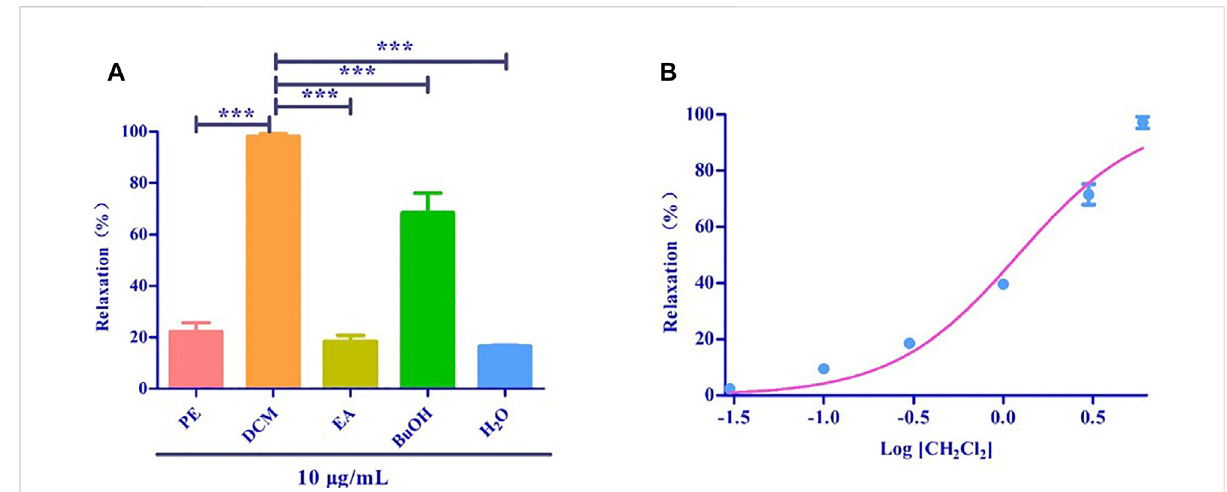
FIGURE 3 (A) Relaxationof different solvent extraction. (B) The cumulative concentration-response curveof the effect of CH on isolated rat aortic rings pre-contracted with PhE (1 μ M). (*** mean p < 0.001 vs. CH 2 Cl 2